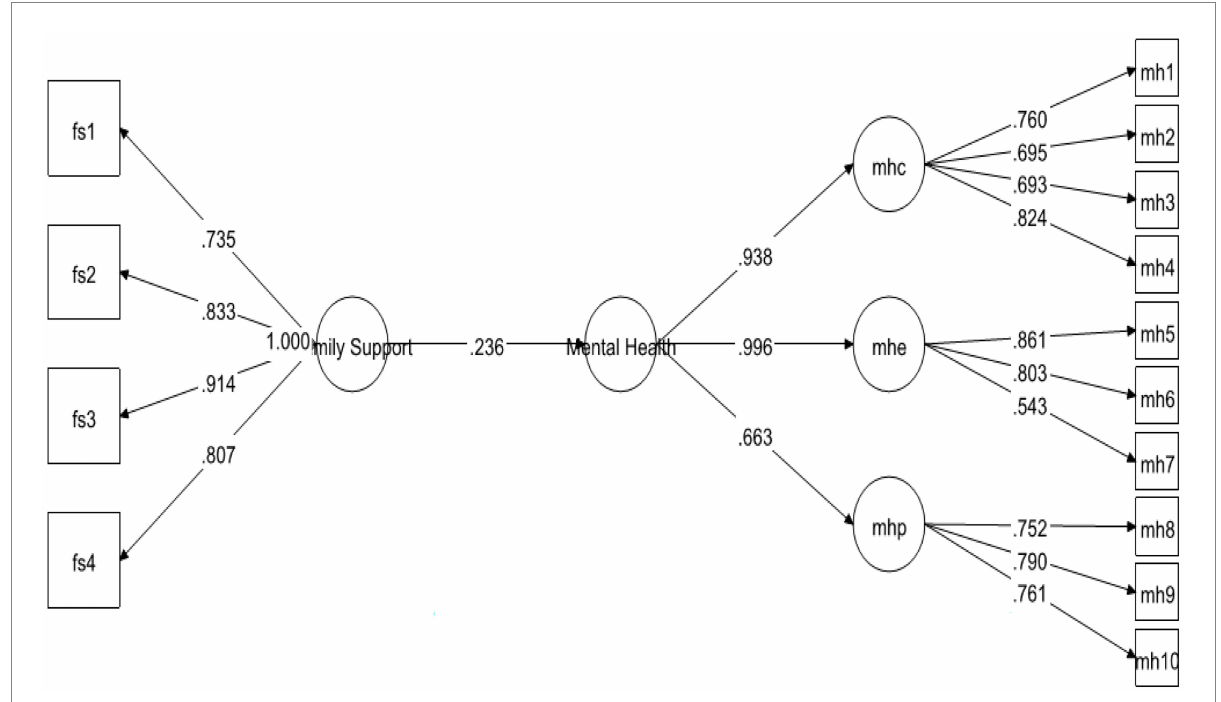
FIGURE 2 Direct relationship between FS and MH.